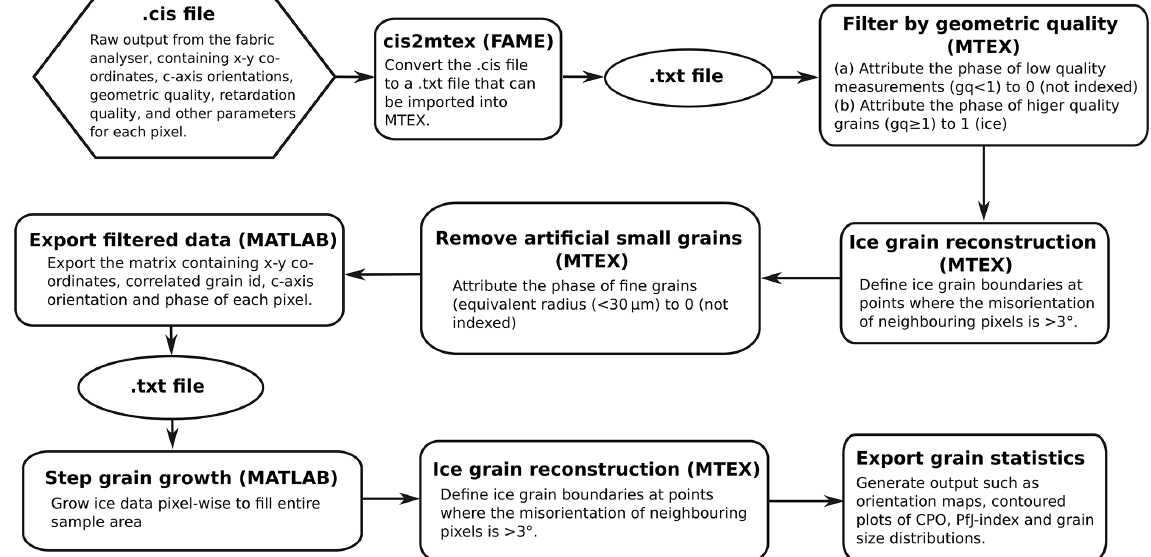
Figure A1. Workflow for microstructural data